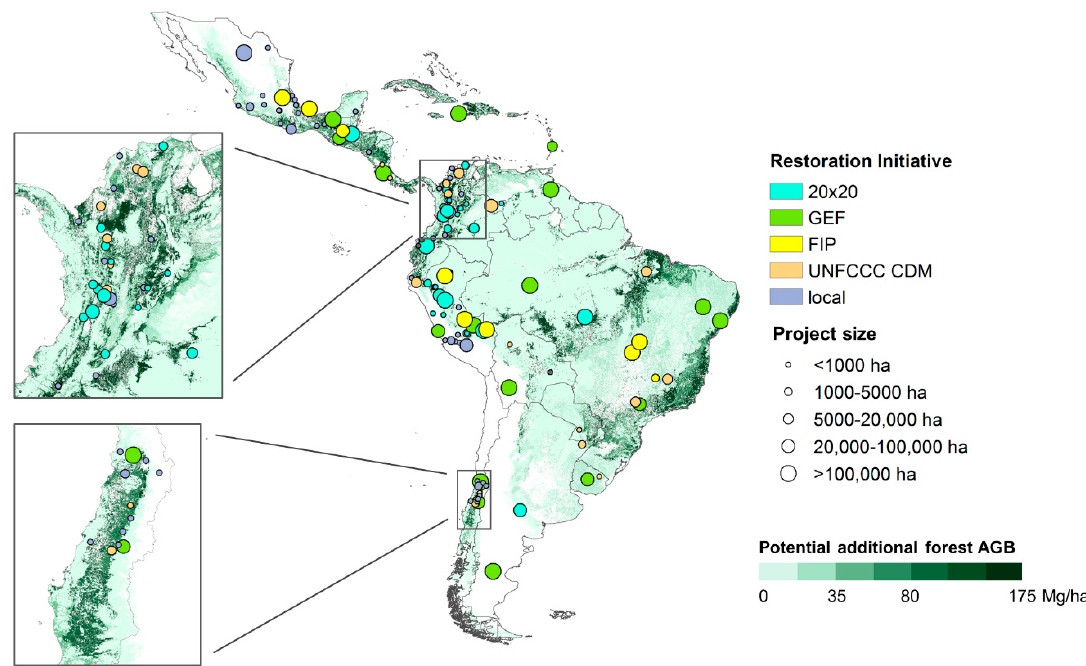
Figure 1. Map of 154 restoration projects in Latin America and the Caribbean projected on the map of potential additional forest aboveground biomass (AGB). The dots represent the centre location of the administrative boundaries of the restoration projects. Two areas in Colombia and Chile are shown in greater detail on the inset maps Note: an earlier version of this map was previously published as Figure 15.2 in Verchot et al.